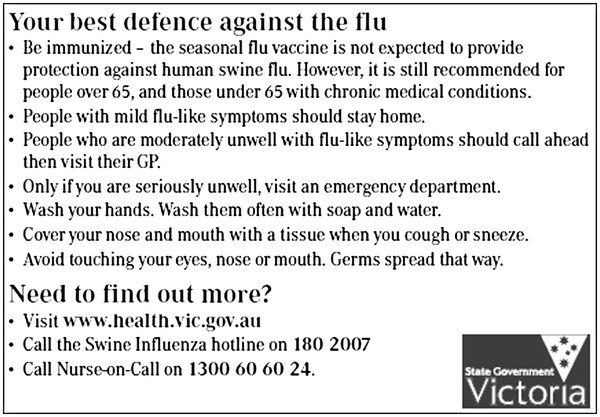
Pandemic (H1N1) 2009.